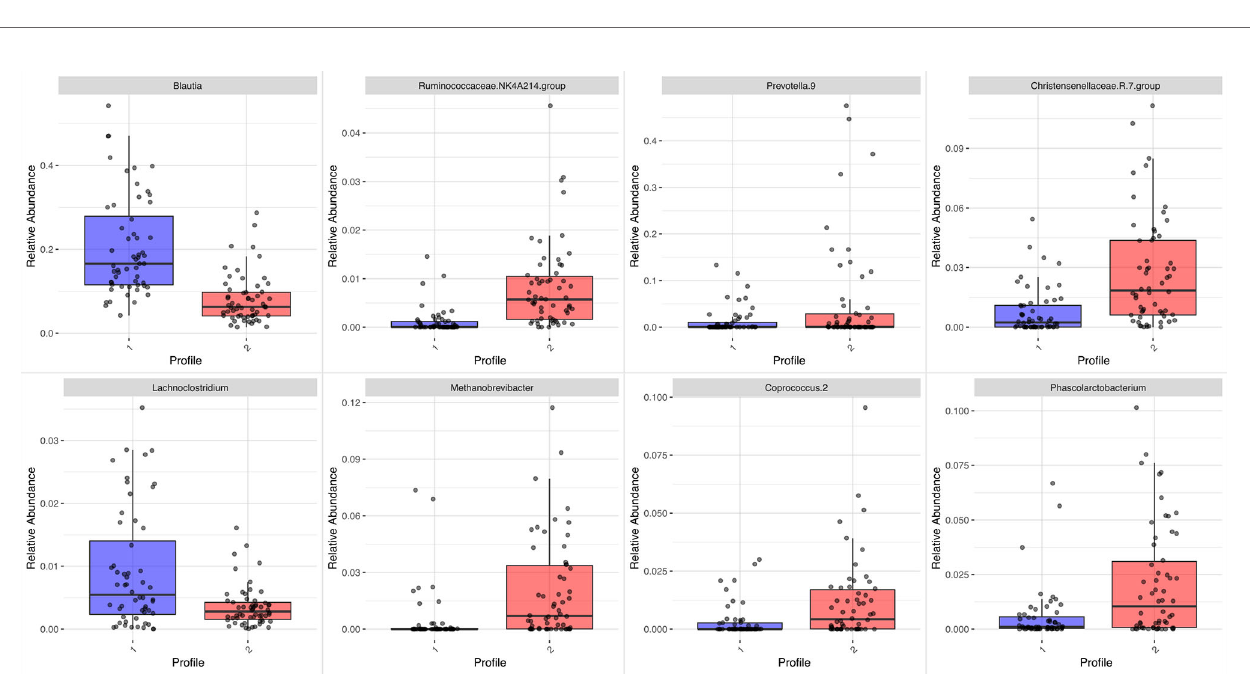
FIGURE 3 | Impact of longer breastfeeding on microbiota composition and adult nutritional status. Credit: Figure produced using Canva graphic design platform (https://www.canva.com/) and brgfx/Freepik.